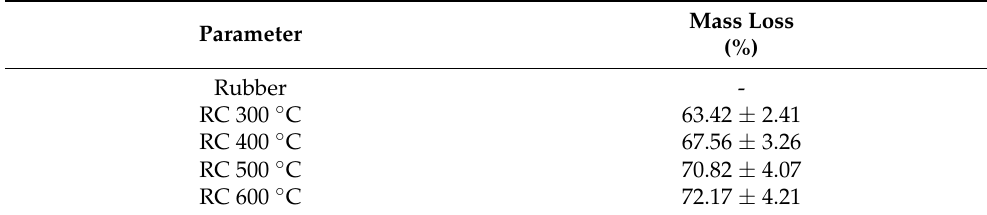
Table 2. Mass loss occurred during each one of the tests conducted at different temperatures.